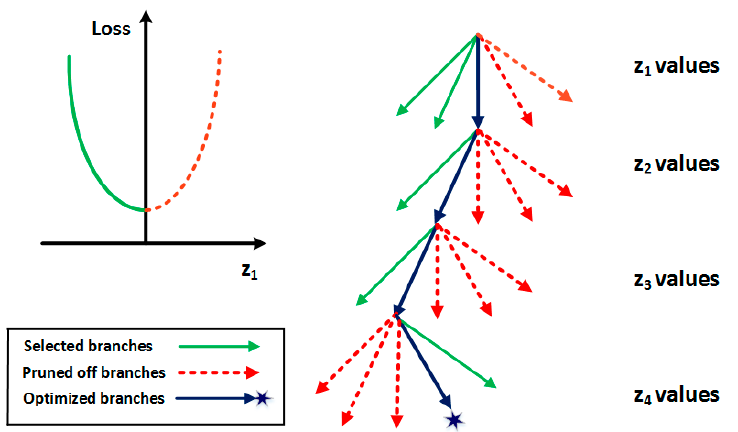
Figure 4. A search tree using an MIQP (Mixed Integer Quadratic Programming) optimization algorithm with pruning.